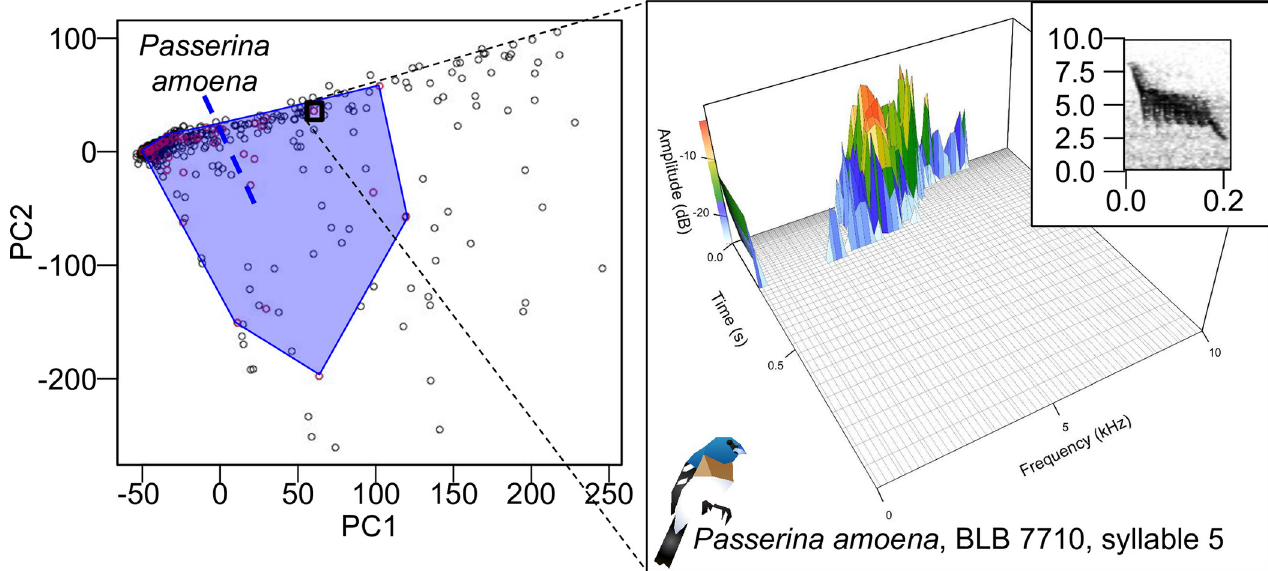
Fig 7. Example hypervolume diagram for one species, Passerina amoena . Left: principal component analysis of SoundShape for 500 syllables (50 per 10 species); with PC1 (x-axis) and PC2 (y-axis). Passerina amoena syllables are shown with red points and a 2-dimensional convex polygon is given to display the 2-dimensional hypervolume. Hypervolume calculation was done 50 times with 50 syllables per species. Right: SoundShape diagram for point indicated in black box on left plot, representing syllable 5 from BLB 7710. X-axis shows the frequency of syllables (kHz). Y-axis shows time (seconds); note this is on a log scale. Z- axis shows amplitude; amplitude is also color-coded on the plot with warmer colors indicating louder amplitude. Inset: original spectrogram representation (see Fig 2).